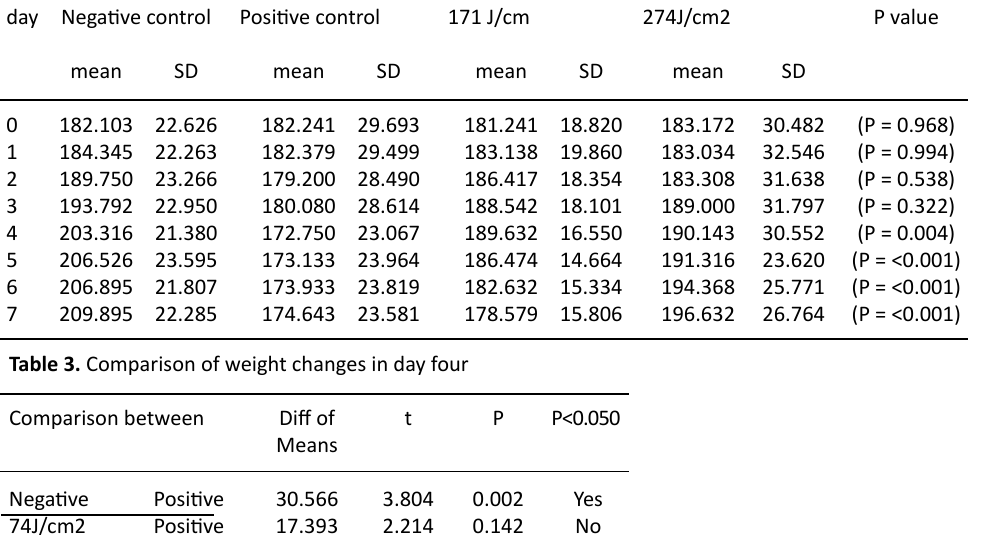
Table 2. Comparison of weight changes